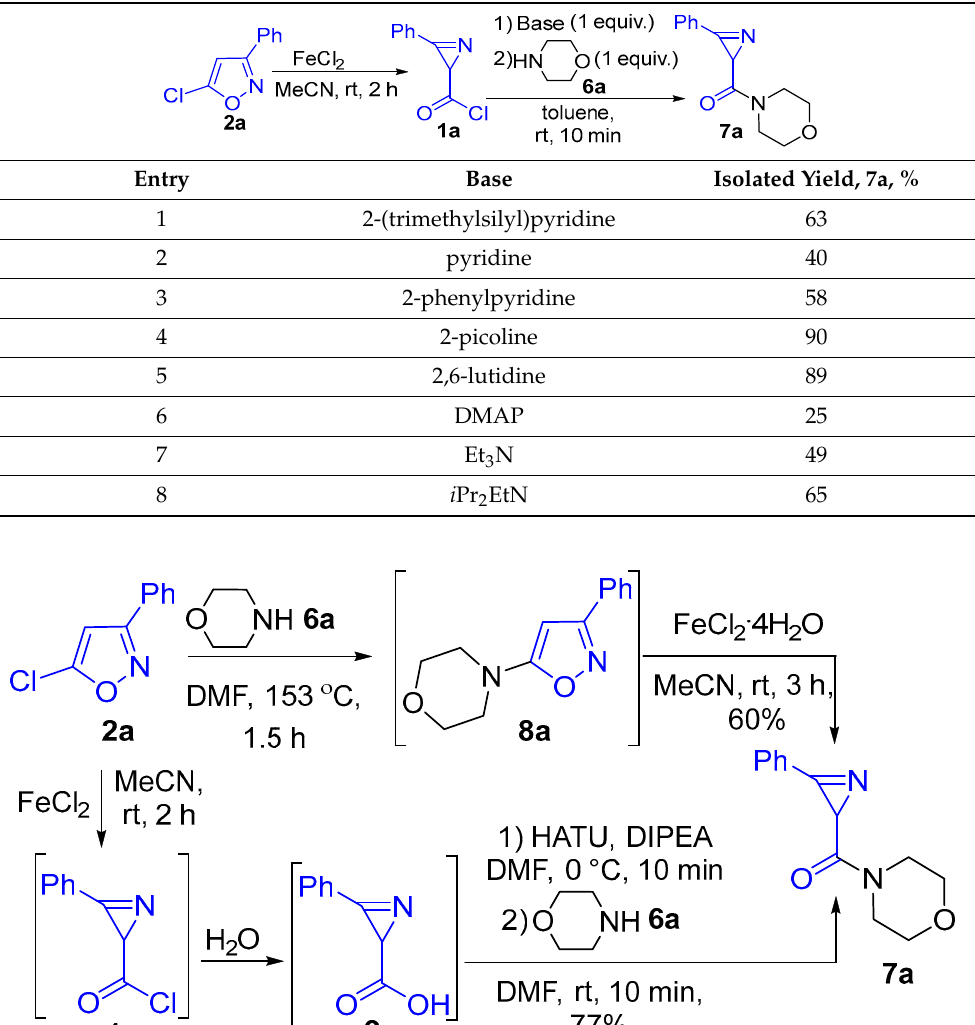
Table 1. Optimization of a base for the synthesis of morpholide 7